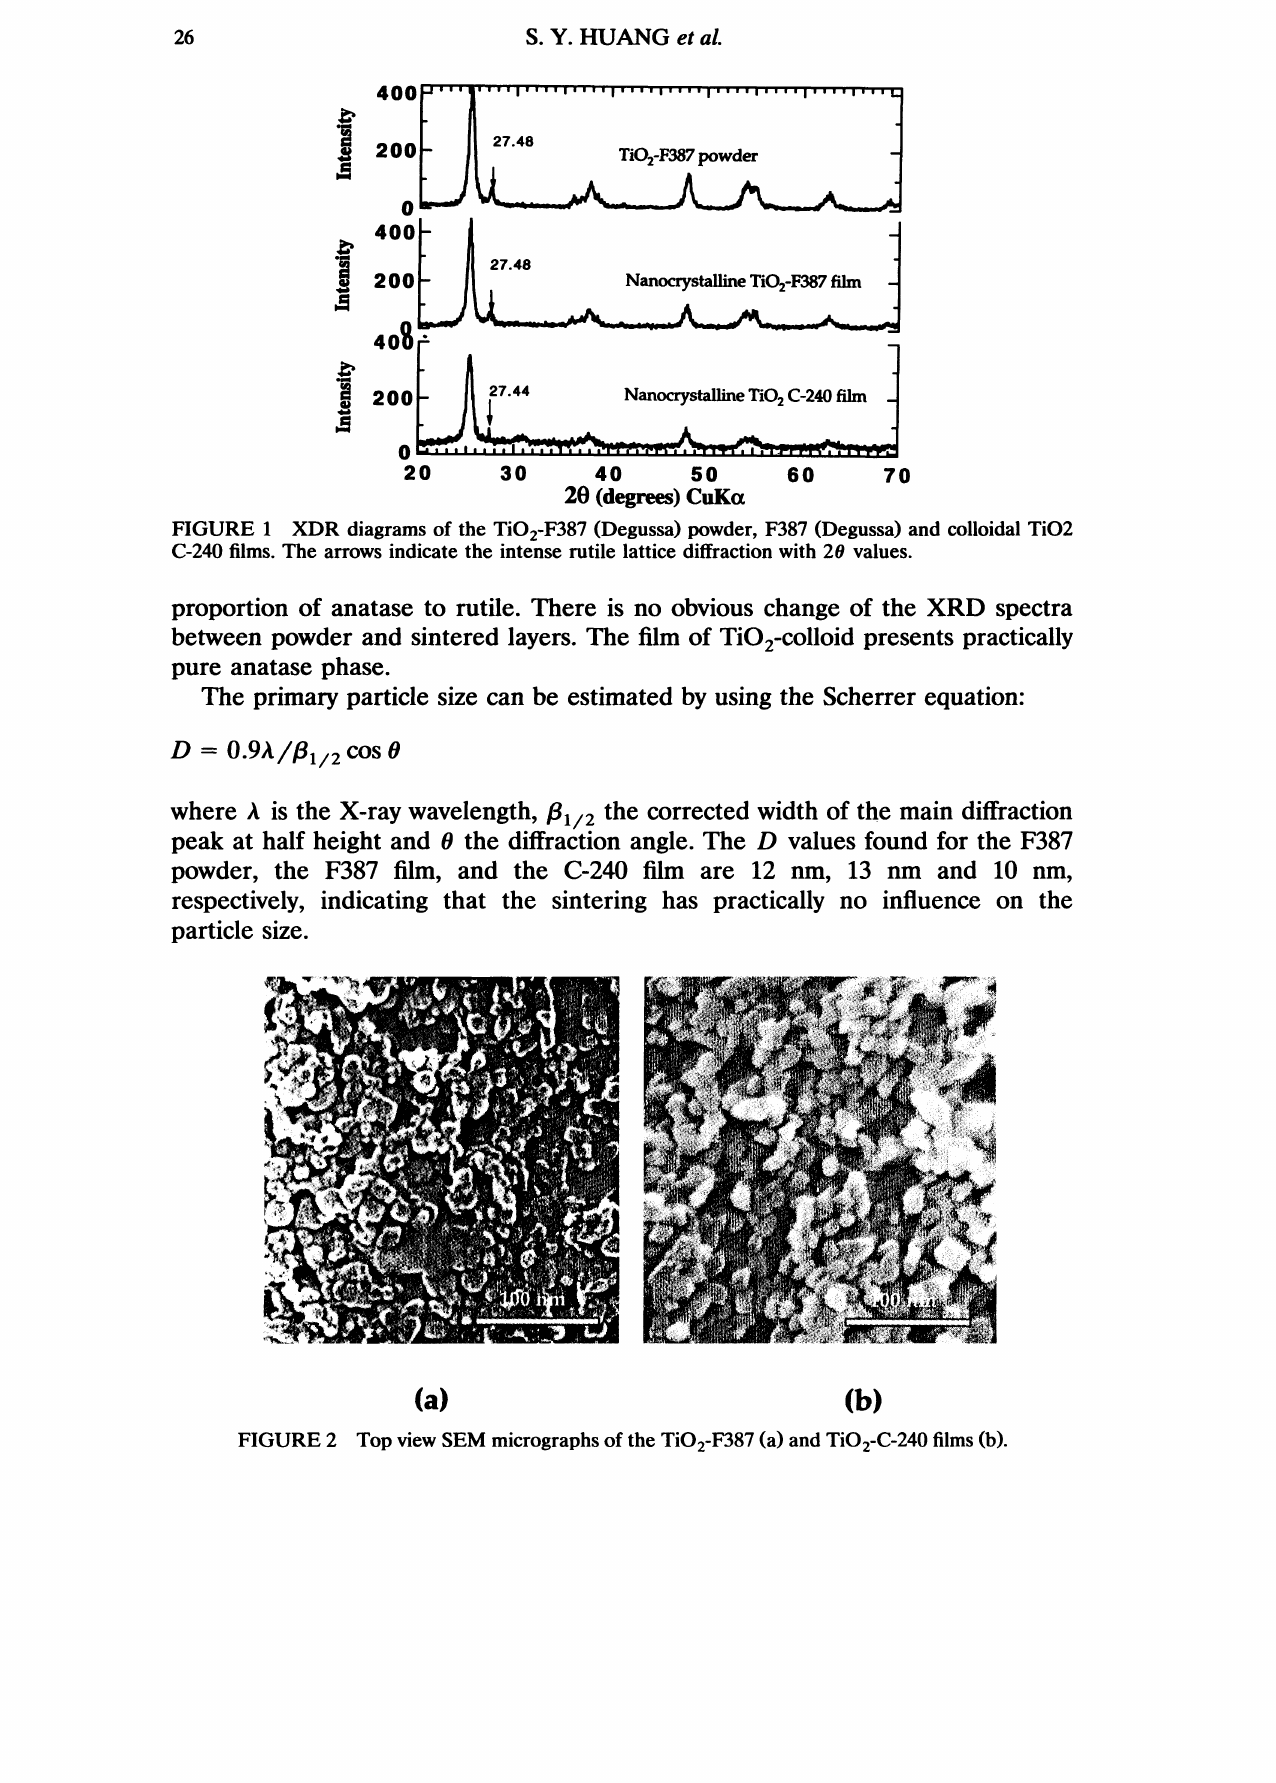
FIGURE 2 Top view SEM micrographs of the TiO2-F387 (a) and TIO2-C-240 films